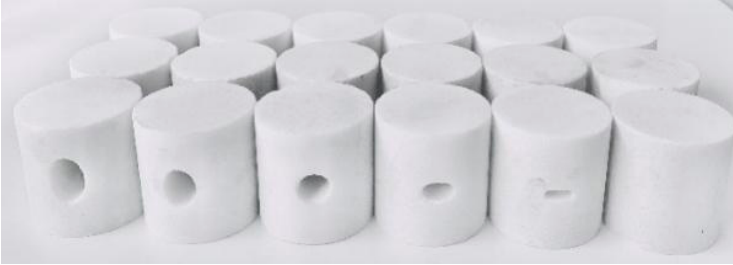
Figure 1. Marble rock samples.